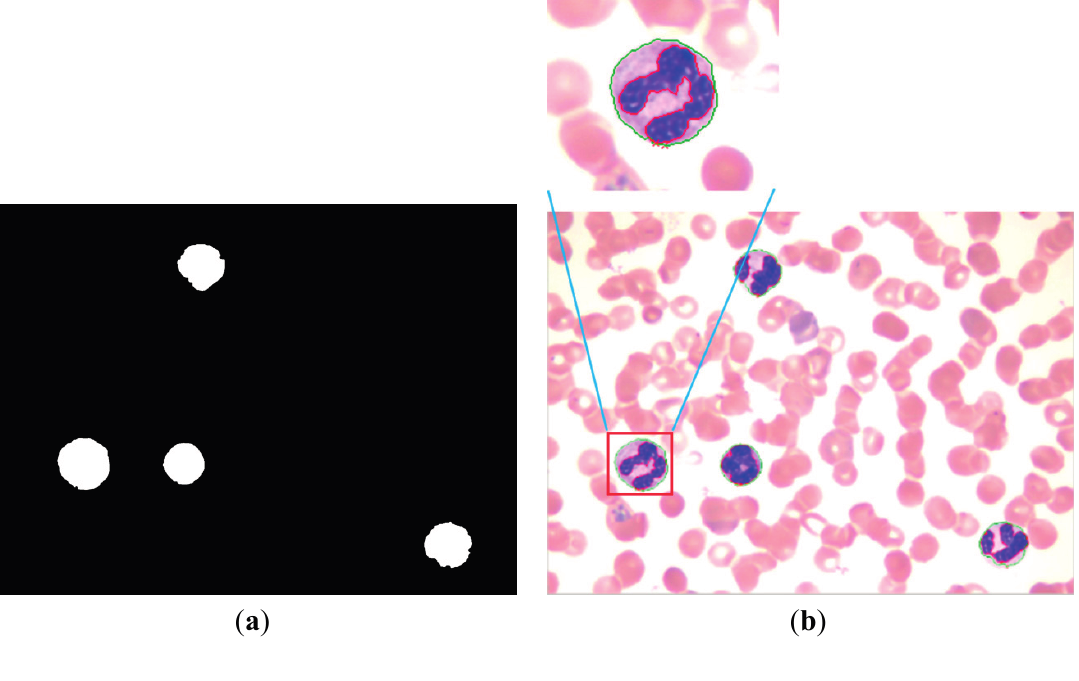
Figure 12. ( a ) WBC segmentation result after denoising; ( b ) Result of WBC nucleus and cytoplasm